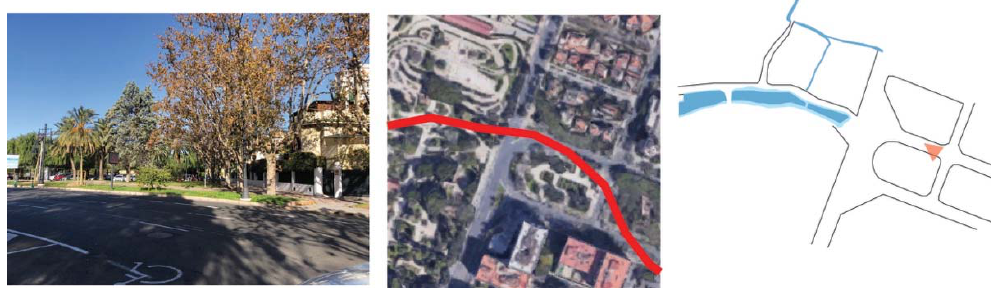
Figure 16. The image of the level differences in the urban area, the satellite image and the diagram of spatial structure created based on the cadaster created between 1929 and 1946 at the same location.